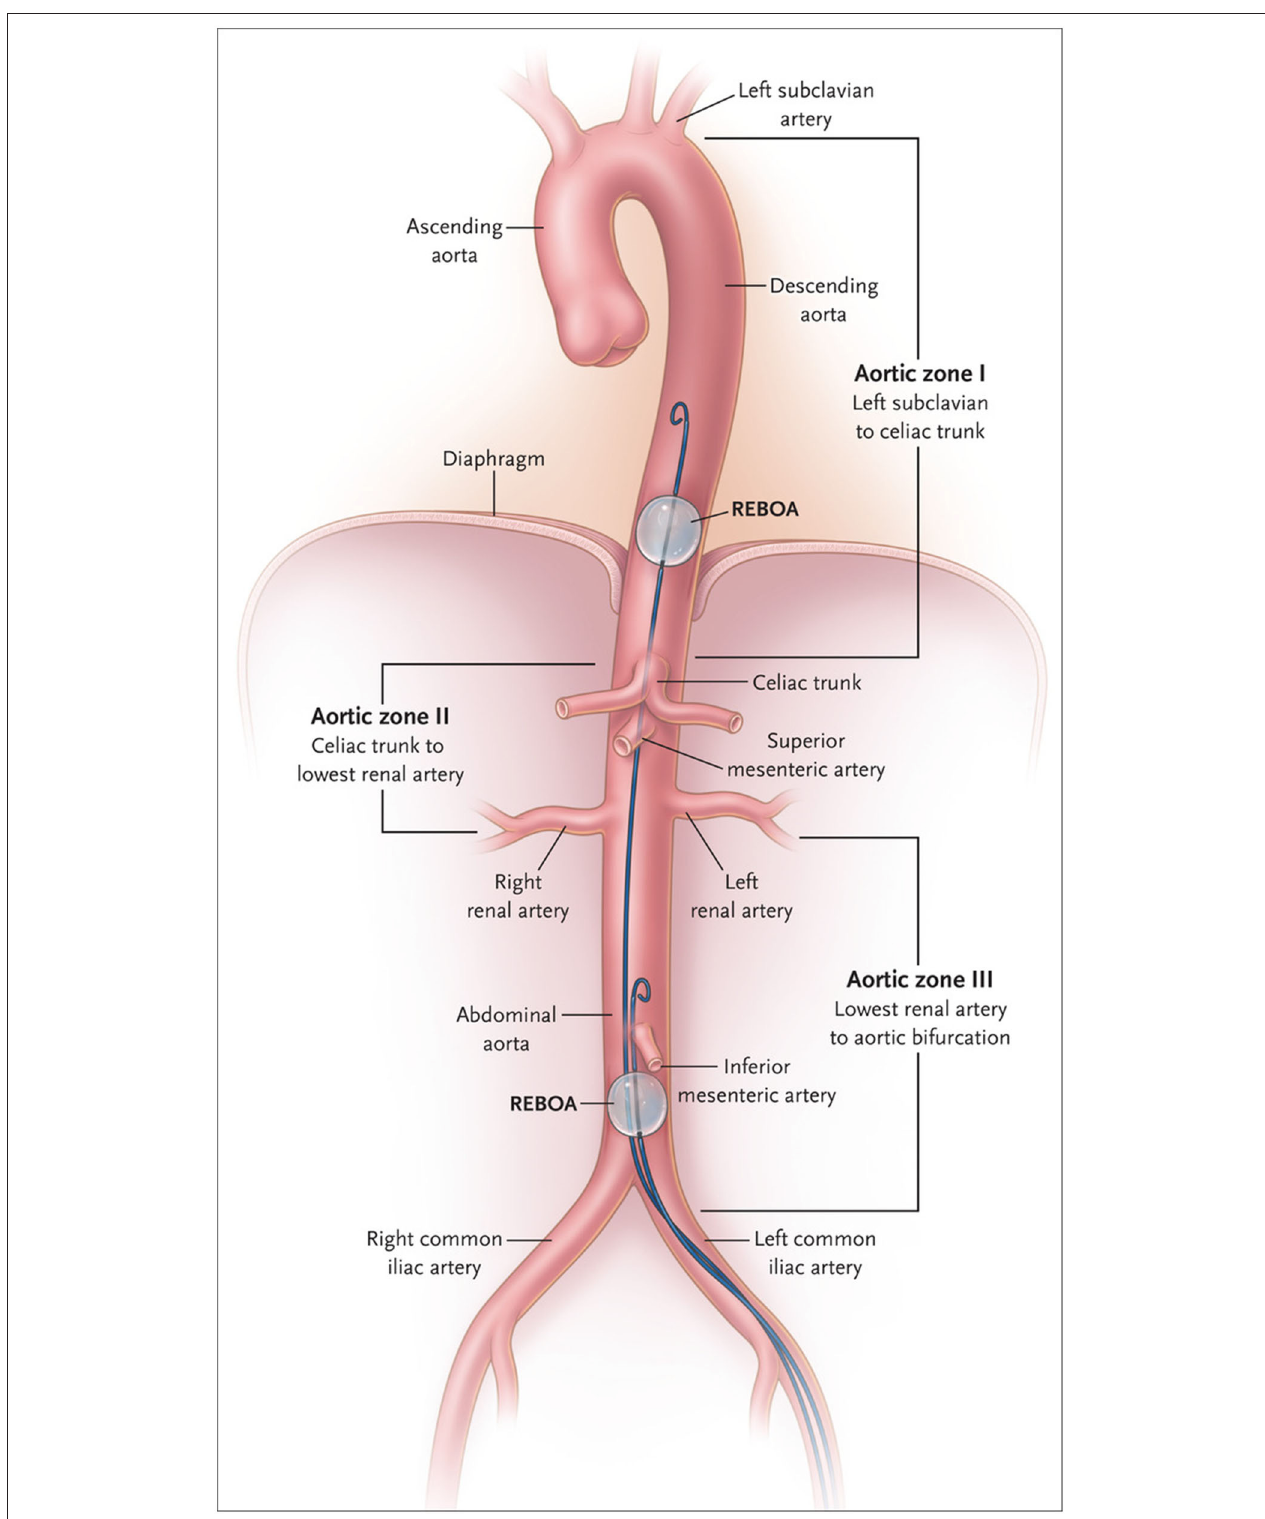
FIGURE 1 | Classification of aortic zone using Resuscitative Endovascular Balloon Occlusion of the Aorta (REBOA). In Zone I, safe positioning of the balloon for control of infradiaphragmatic hemorrhage is shown; in Zone III, positioning for control of massive pelvic hemorrhage in the absence of a simultaneous abdominal source of hemorrhage is shown. From King (11). Copyright © 2022 Massachusetts Medical Society. Reprinted with permission from Massachusetts Medical Society.